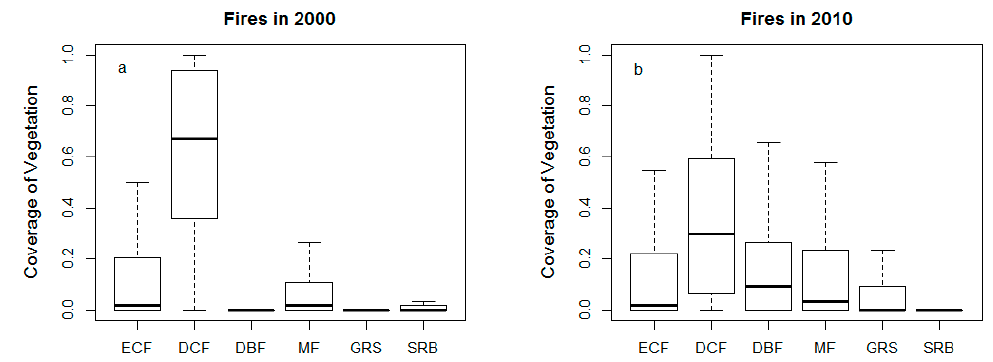
Figure 9. An overview of the pre-fire vegetation composition within fires of 2000 ( a ) and 2010 ( b ). Variable abbreviations were described in Table 2.